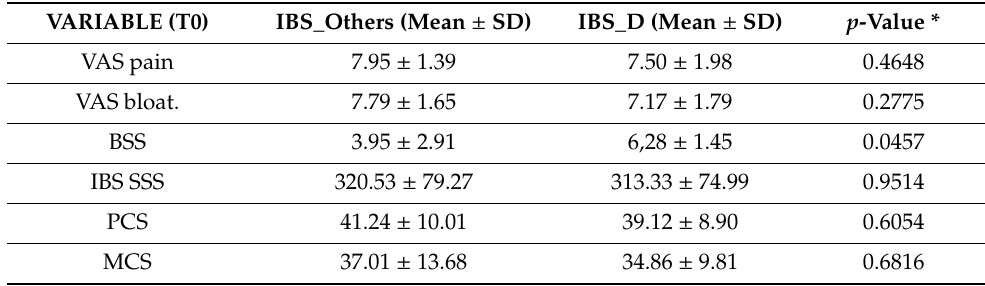
Table 3. Score values: Visual Analogue Scale (VAS) bloating and VAS pain (0–10); Bristol stool chart (1–7); Irritable Bowel Syndrome Severity Scoring System (0–500); physical component summary and mental component summary side